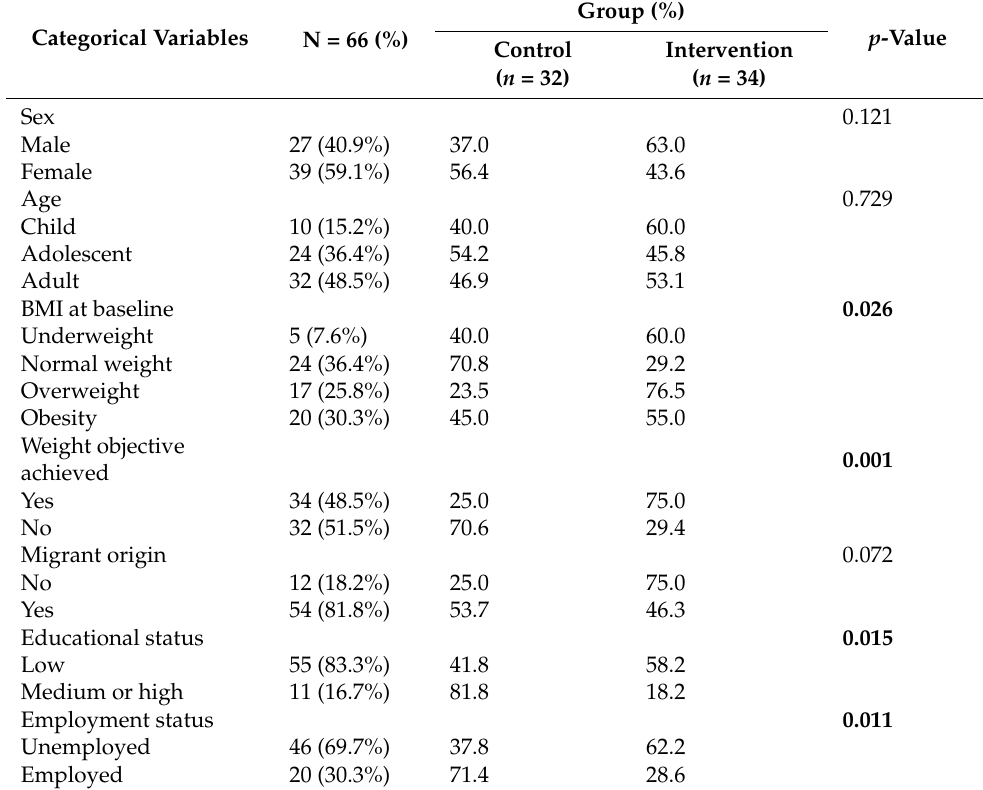
Table 1. Sociodemographic and anthropometric characteristics of the sample (children, adolescents, and adults).